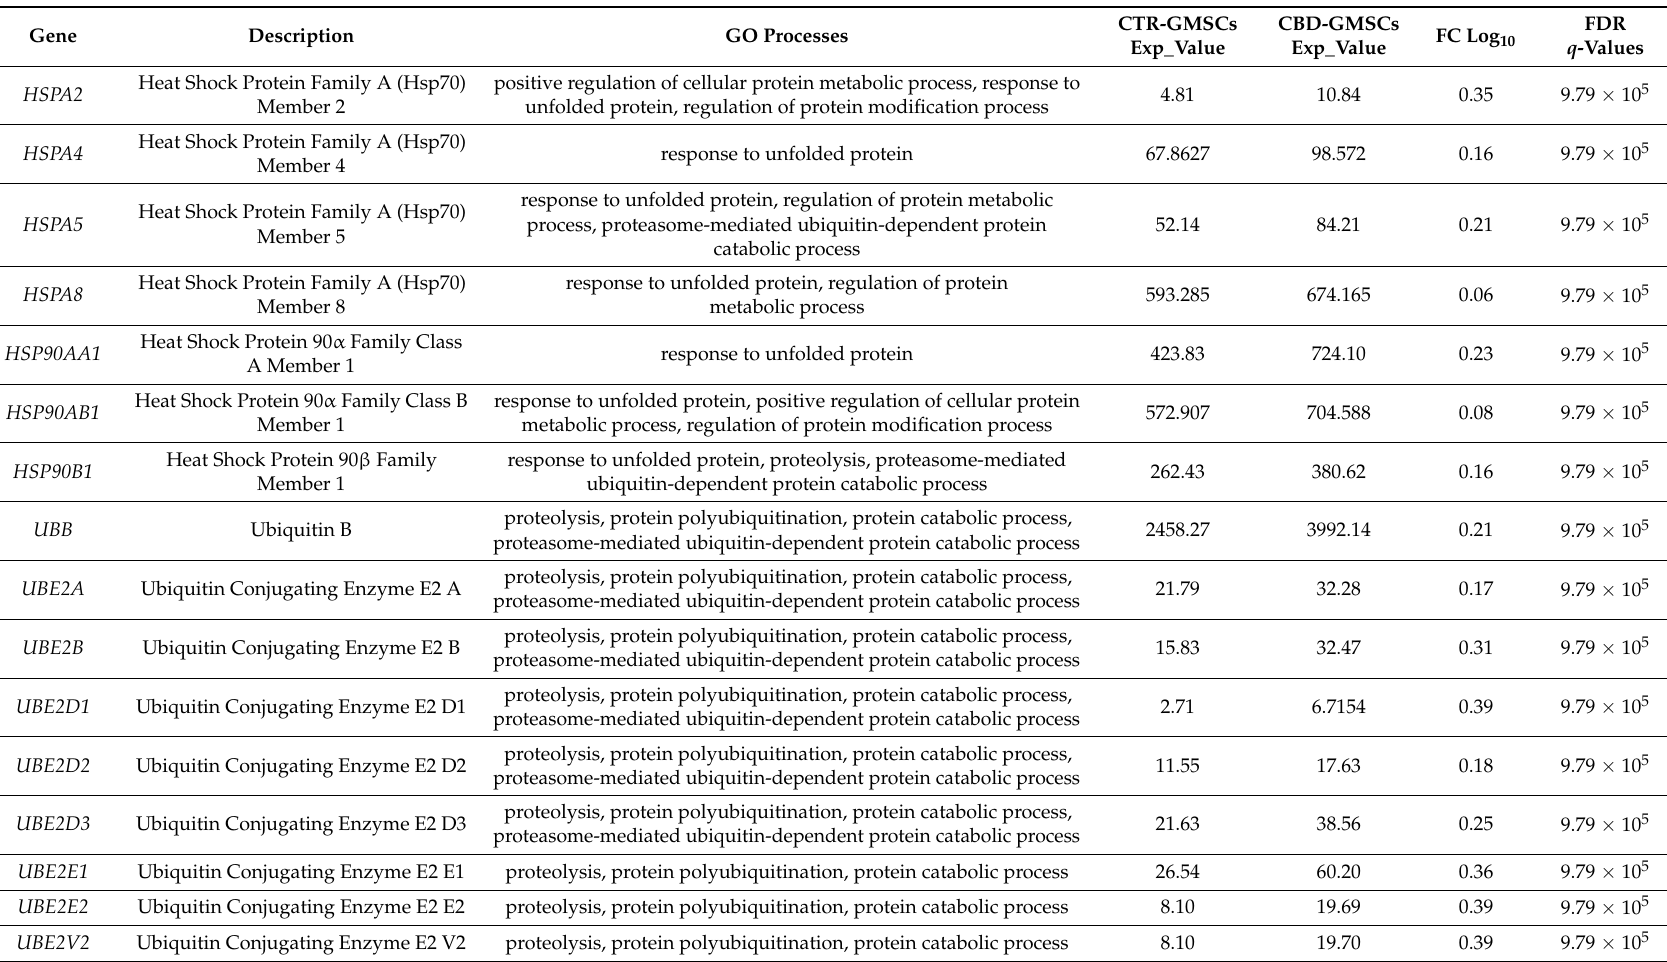
Table 2. CBD treatment upregulated the expression of genes linked to catabolic protein processes, response to unfolded protein and protein polyubiquitination. The differential expression between CBD-GMSCs and CTR-GMSCs is given in FC Log 10 . GO processes indicate the gene classification in different biological processes. Instead, the statistical significance is indicated by FDR, q -values ≤ 0.05 were considered statistically